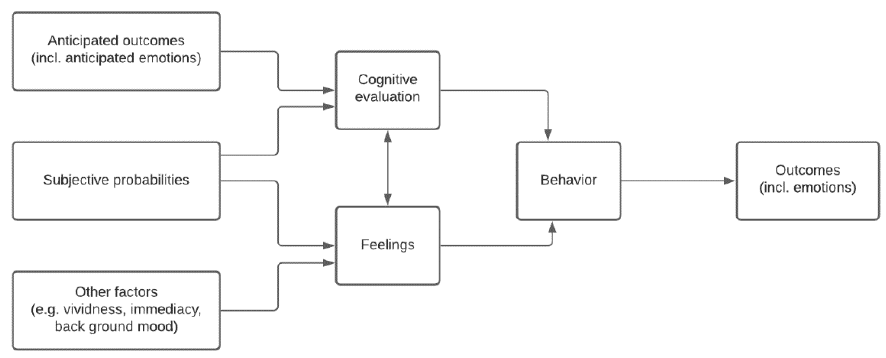
Figure 1. Risk-as-emotions hypothesis. Source: [20].